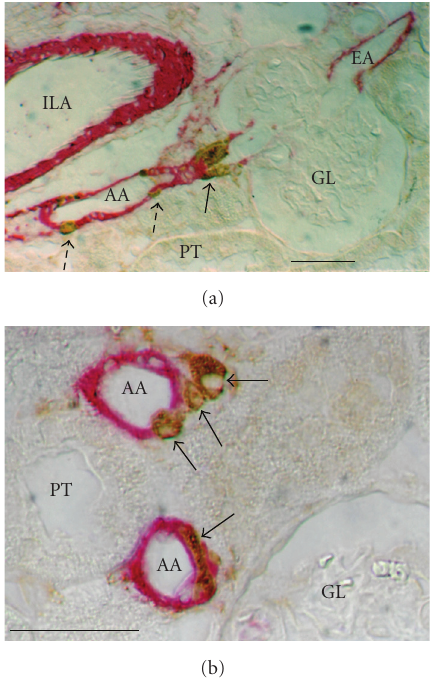
Figure 1: Microscopic views of para ffi n kidney sections from a rat chronically treated with the converting enzyme inhibitor captopril (30mg per day for 7 weeks per os; Sigma, St Louis, MO). Sections were double-stained against α -smooth muscle actin (red label, monoclonal anti- α -SM actin, clone # 1A4, 1 : 1000 dilution, Sigma), and against renin (brown label, polyclonal anti- rat renin antibody, ref. # 936, 1 : 10,000 dilution, gift from T. Inagami, Vanderbuilt University, Nashville, TN), using Dako En Vision Doublestain System (Ref. K1395, Dako A/S, Glostrup, Denmark). (a) A juxtamedullary glomerulus (GL) with its a ff erent (AA) and e ff erent arterioles (EA), close to an interlobular artery (ILA), and proximal tubules (PT). Renin cells accumulate near the glomerular vascular pole (single arrow) and other renin cells were recruited upstream along the a ff erent arteriole (dashed arrows). (b ) Enlarged view of two transversally cut a ff erent arterioles (AA) near a glomerulus (GL). Arrows point to individual granulated renin cells (brown label) that exhibit a variety of topologies with respect to smooth muscle cells (red label). The renin cell in the lower arteriole is included within the arteriolar wall between smooth muscle cell processes. In the upper arteriole, one renin cell (lower arrow) is part of the arteriolar wall, whereas the upper two renin cells are located on top of the smooth muscle cell layer. Regarding the latter two observations, it is interesting to note that recent studies in connexin 40-deficient mice [82] unveiled a “topological escape” of renin- cells away from a ff erent arterioles towards the extraglomerular mesangium. Bars: 50 μ